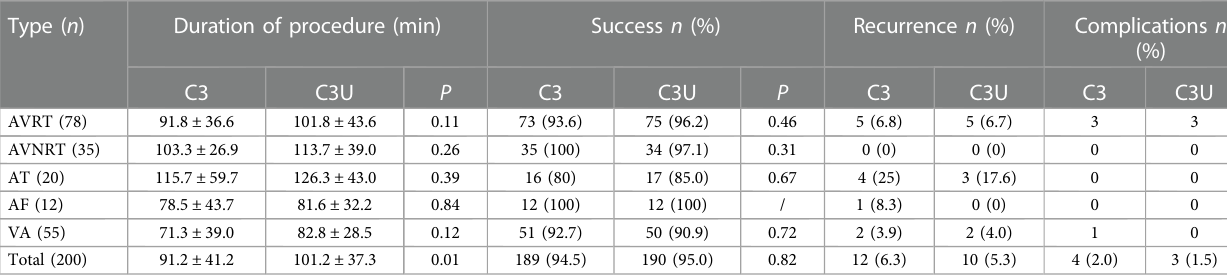
TABLE 1 Comparison of ablation outcomes between the C3 and C3U groups ( n =200). Type ( n